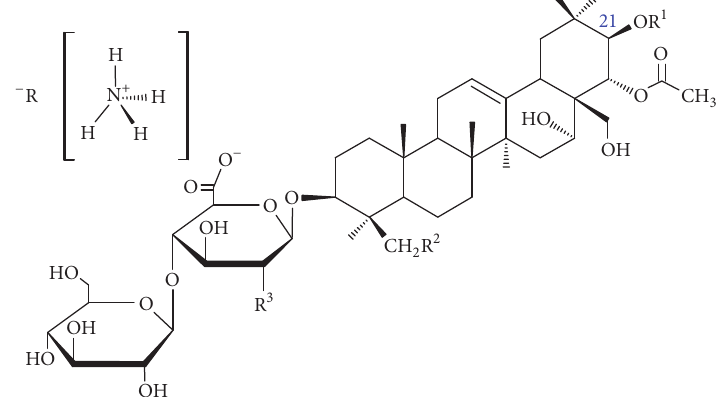
Figure 6: The scheme of possibility of ionic binding ammonium group of polymer with the carboxyl group of escin.